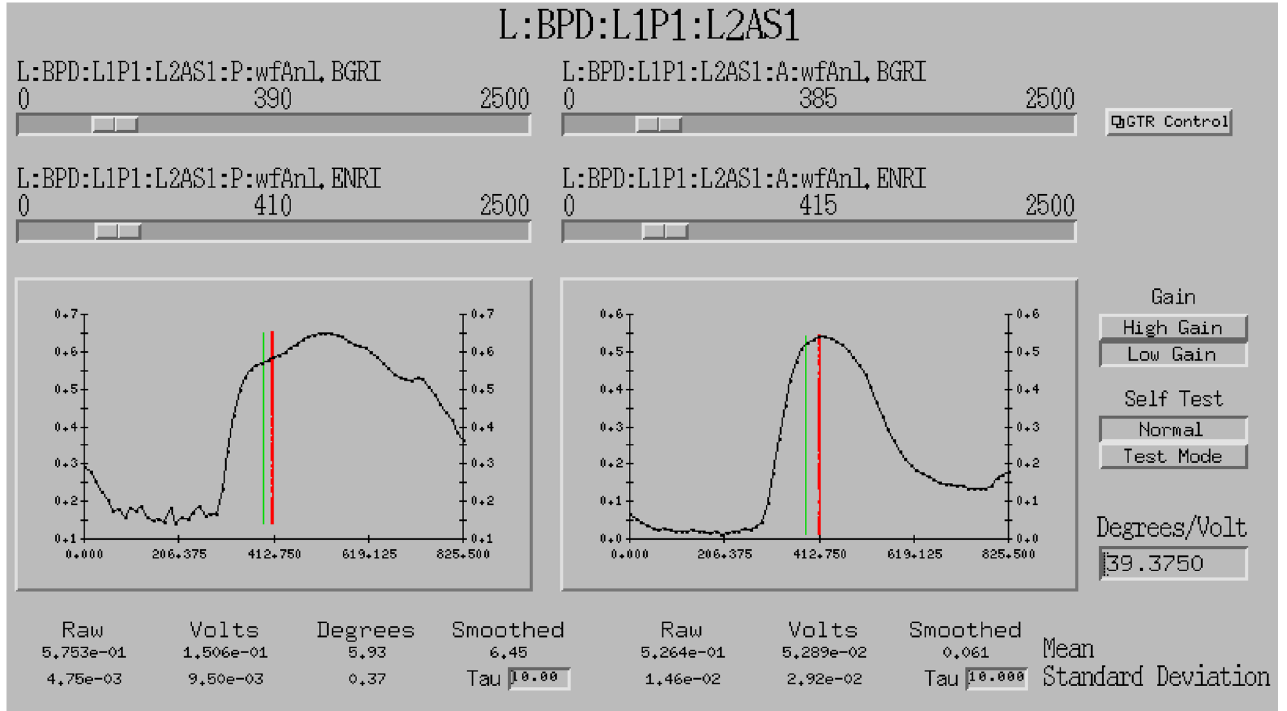
FIG. 4. (Color) EPICS waveform and scalar process variable phase detector engineering screen showing phase (left plot) and amplitude (right plot) waveforms vs time. The red and green lines specify the time range over which the phase detector acquires data and obtains the phase and amplitude. Time units are ns.